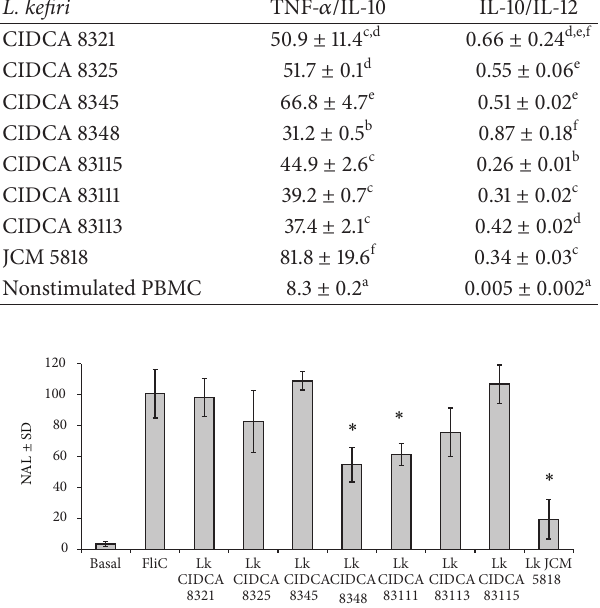
Figure 1: Modulation of proinflammatory response in Caco-2 ccl20:luc reporter system by L. kefiri strains. NAL: normalized average luminescence expressed as percentage of activity induced with flagellin stimulation; FliC: Salmonella -isolated flagellin; Basal: without any stimulation. Results are expressed as mean ± standard deviation and are representative of at least three independent experiments. ∗ 𝑃 < 0.01 .